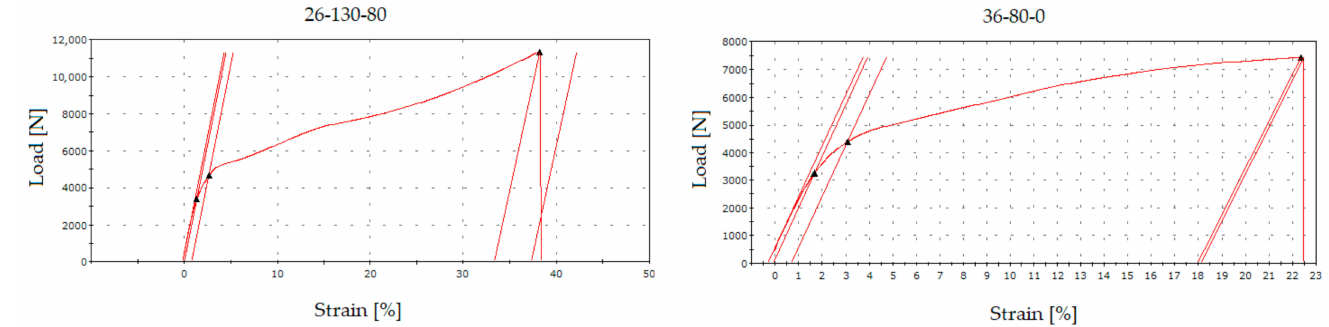
Figure 11. Comparison of tensile diagrams of group “0” for fabrics type “130” and “80”.